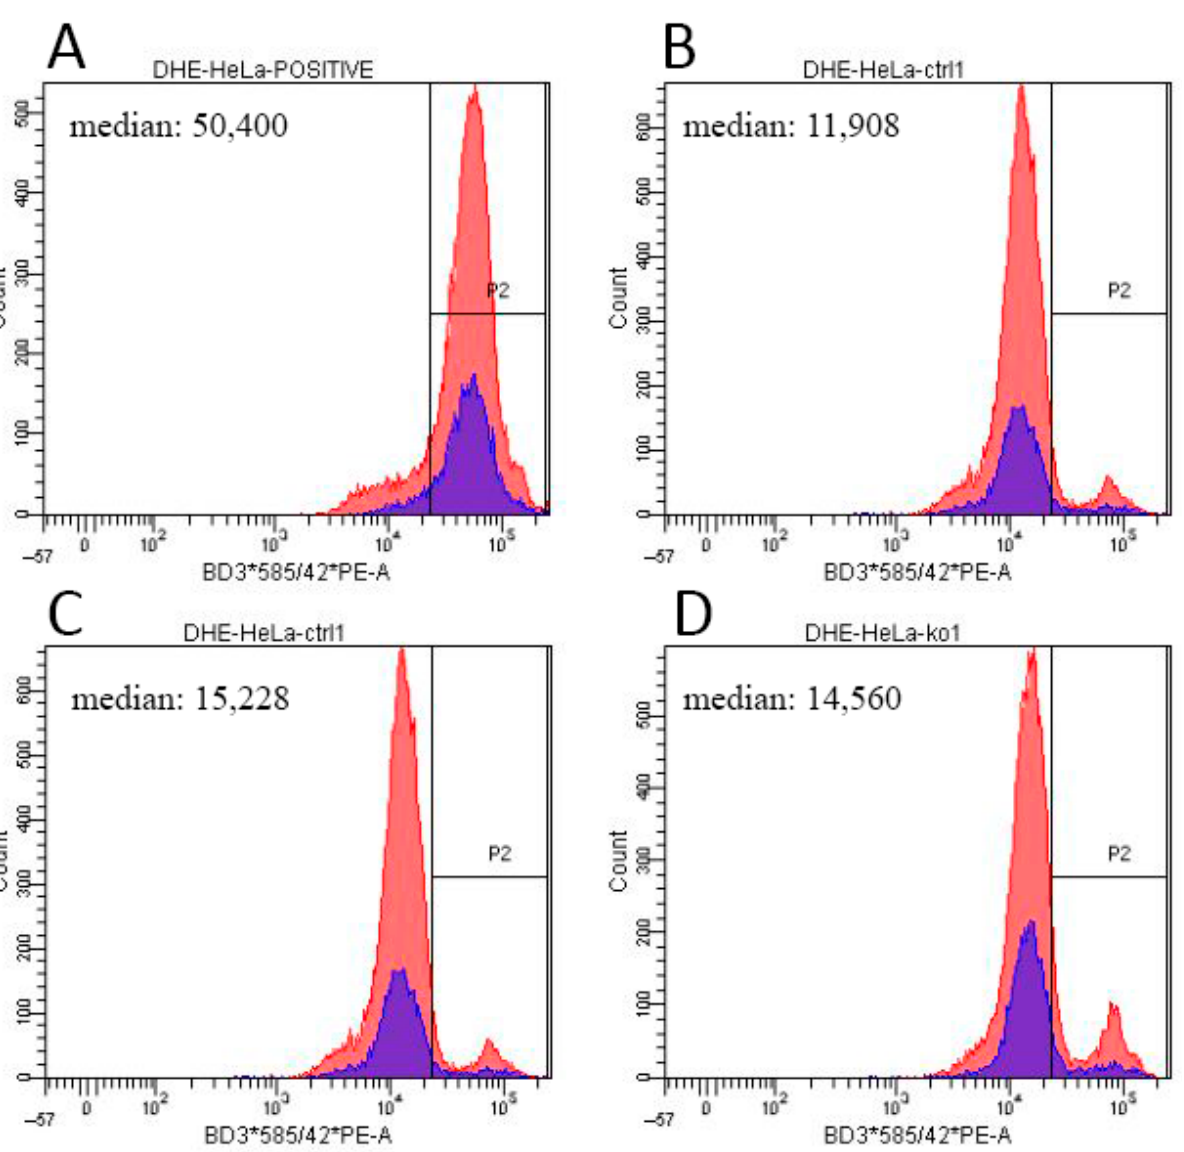
Figure A5. ROS detection by flow cytometry after DHE staining. Histogram plots show the fluorescent signal distribution in ( A ) a positive control treated with 100 µ M menadione, two control cell lines (( B ) HeLa WT1 and ( C ) WT2), and ACBD3-KO cell line ( D ) B3-KO. x -axis: fluorescence intensity; y -axis: cell count. In case of HeLa ABCD3-KO, ROS production remained similar to controls.